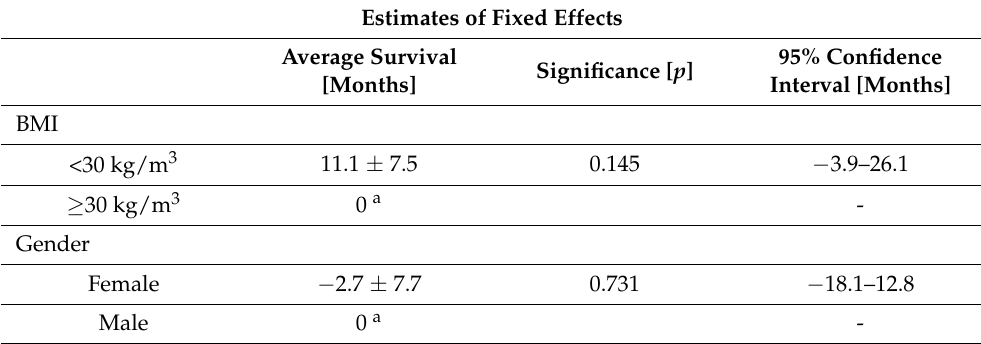
Table 3. The impact of demographic parameters on average TKA survival (mixed model